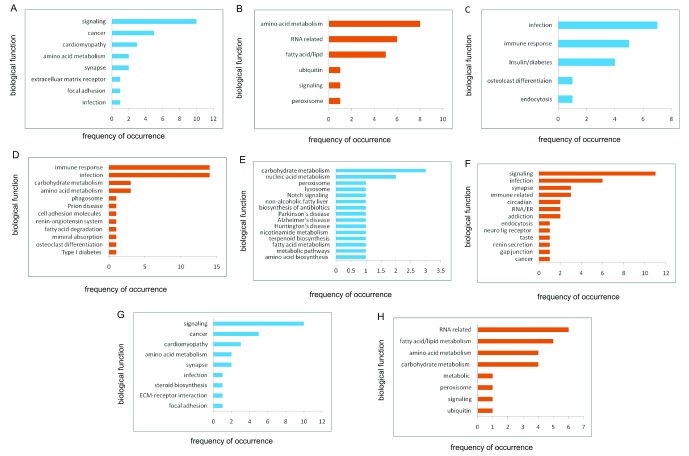
Pathway enrichment.KEGG pathway categories for female gene correlates. (
A) Positive correlates and (
B) negative correlates, frontal white matter; (
C) positive correlates and (
D) negative correlates, hippocampus; (
E) positive correlates and (
F) negative correlates; parietal cortex; (
G) positive correlates and (
G) negative correlates, temporal cortex. X-axis, frequency of occurrence; Y-axis, biological function.